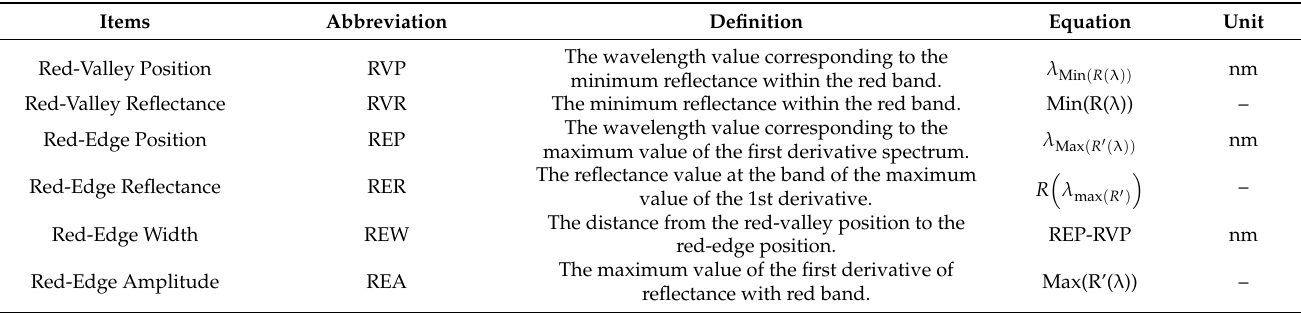
Table 2. Definitions and equations for 6 red-edge